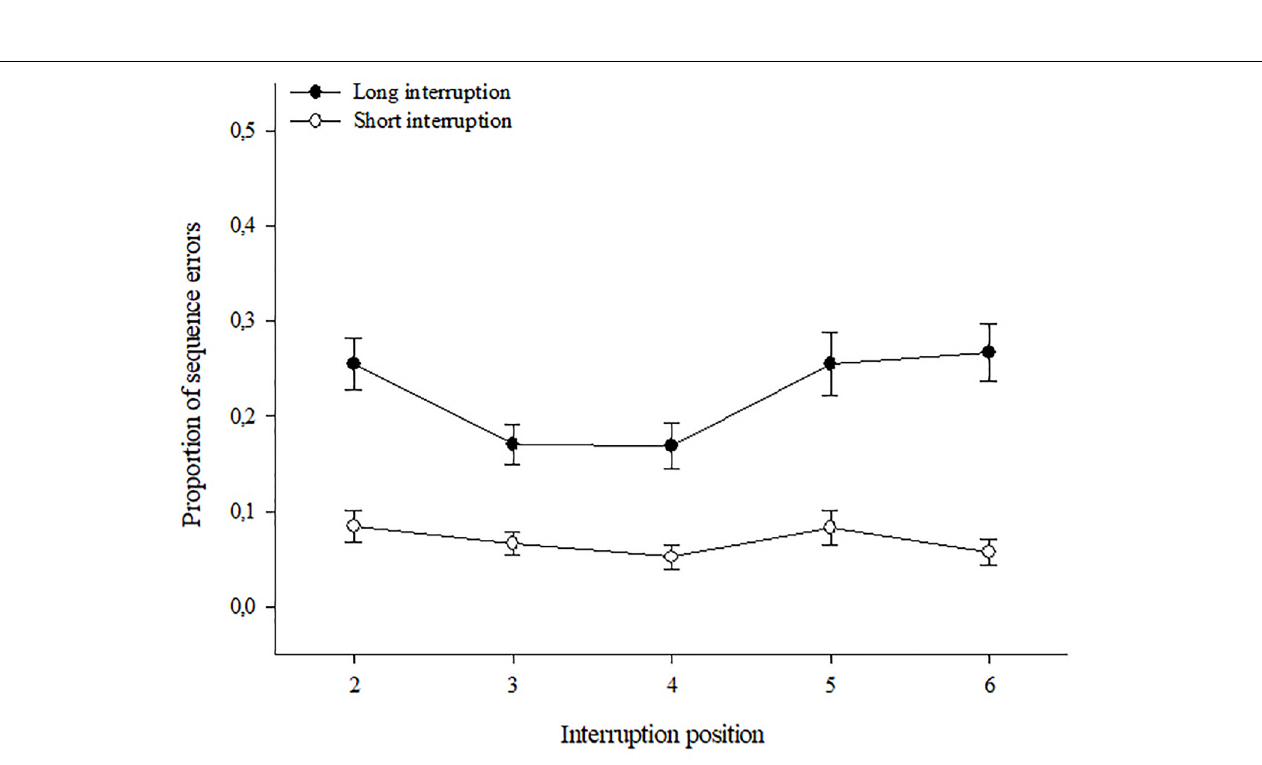
FIGURE 3 | Proportion of sequence errors and standard errors of the acronym and no-acronym groups together at different interruption positions.